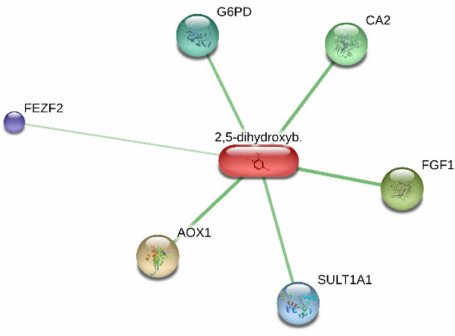
Figure 7. Target component analysis conducted on the STITCH bioinformatics platform for unraveling putative interactions between prominent extracts’ phytochemicals and putative proteins involved in inflammatory and cytotoxicity effects.